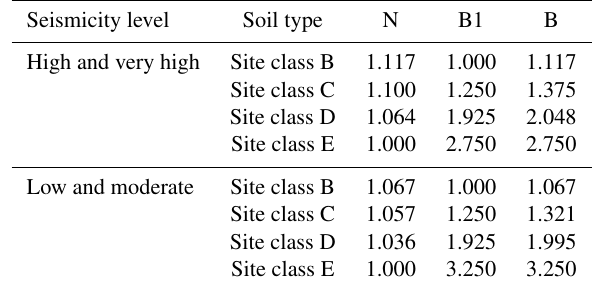
Table 2. Reflection factor for 1s